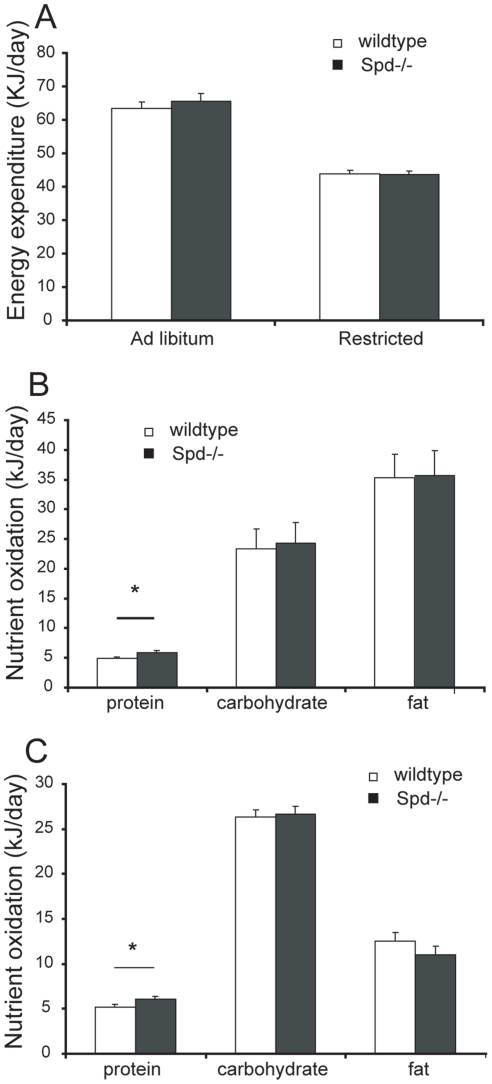
Heat exchange in 28 week old Spd−/− and wild-type mice.A) Heat exchange per animal was not significantly different between genotypes. B) Nutrient oxidation in ad libitum fed mice. Protein oxidation showed a borderline genotype effect, * p = 0.049. C) Nutrient oxidation in restricted fed mice. Protein oxidation showed a genotype effect, * p = 0.035. Data are least square means + SE, n = 11–12.